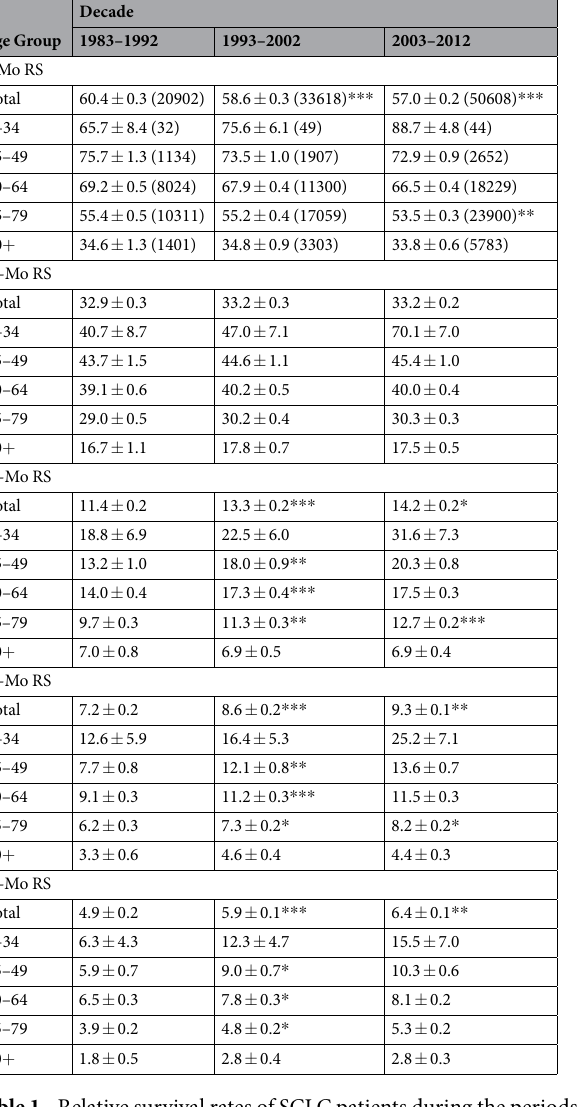
Table 1. Relative survival rates of SCLC patients during the periods of 1983–1992, 1993–2002, and 2003– 2012 at 18 SEER sites. Data are mean ± standard error of the mean, with number of patients in parentheses. Abbreviations: Mo, month; RS, relative survival; SEM, standard error of the mean. * p < 0.01, ** p < 0.001, and *** p < 0.0001 for comparisons with the preceding